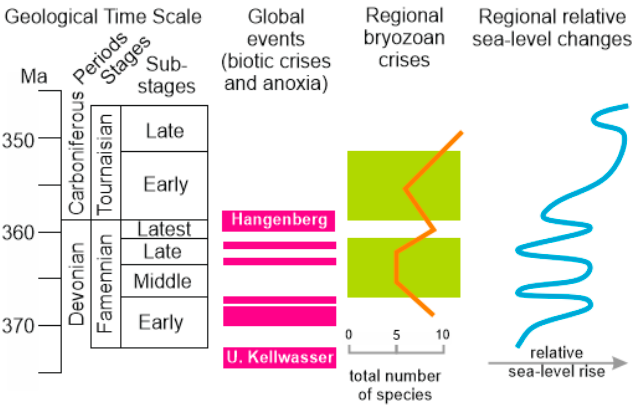
Figure 5. Correlation of the global and regional events (created by the authors; the geological time scale follows [29], the global events are shown according to [1], the regional bryozoan events are interpreted in this study (see text for more explanations), and the regional relative sea-level changes follow the reconstruction [25] and taking into account the information from [27]). All shown patterns are justified to substages.